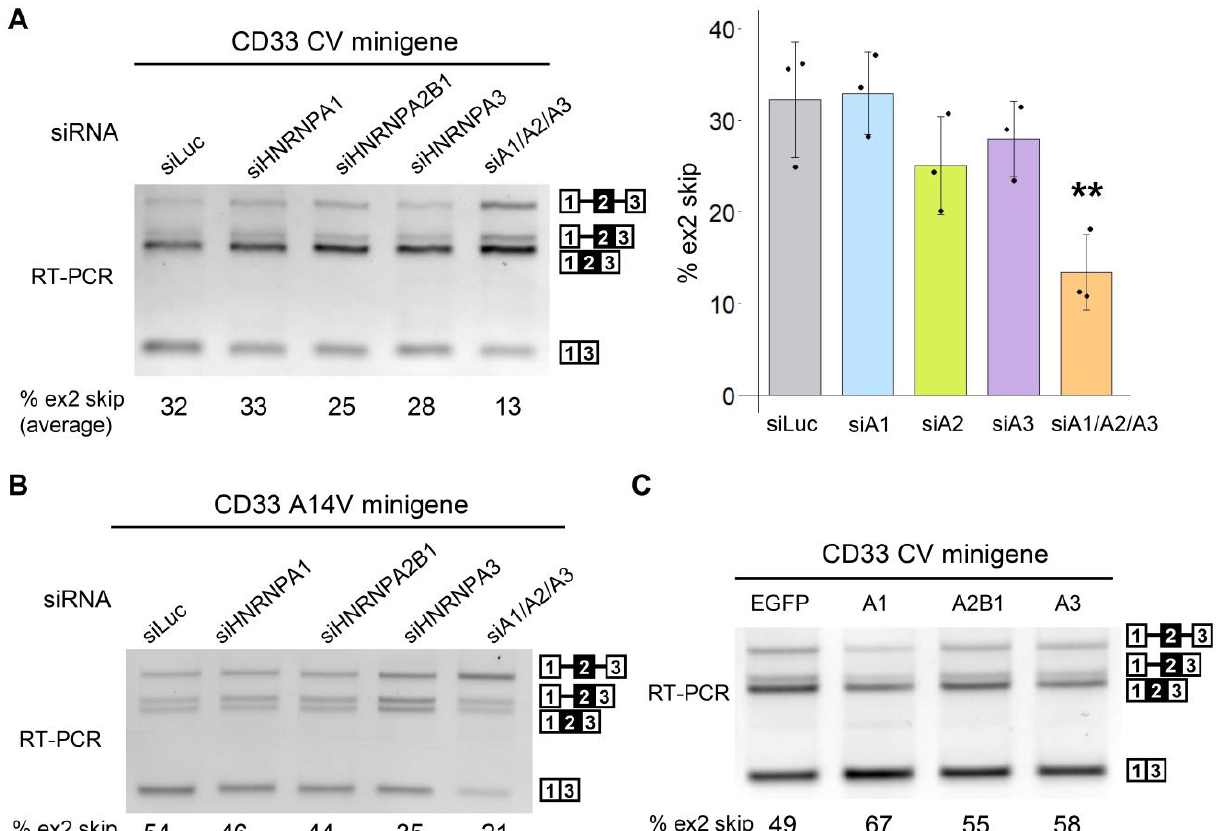
Figure 2. Alternative splicing of CD33 exon 2 is regulated redundantly by the HNRNPA family proteins. ( A ) RT-PCR products of the CD33 CV minigene in HEK cells treated with siRNA were resolved with agarose gel electrophoresis ( left panel ). The bar chart shows the portion of exon 2 skipping ( right panel ). Error bars represent the SD ( n = 3). Tukey’s test was used for statistical evaluation (** p = 0.0063, in comparison with siLuc). ( B ) HEK cells were transfected with the A14V minigene and siRNA against the HNRNPA family and were analyzed in the splicing assay. ( C ) HEK cells were transfected with EGFP or EGFP-fused HNRNPA proteins and were analyzed in the splicing assay.